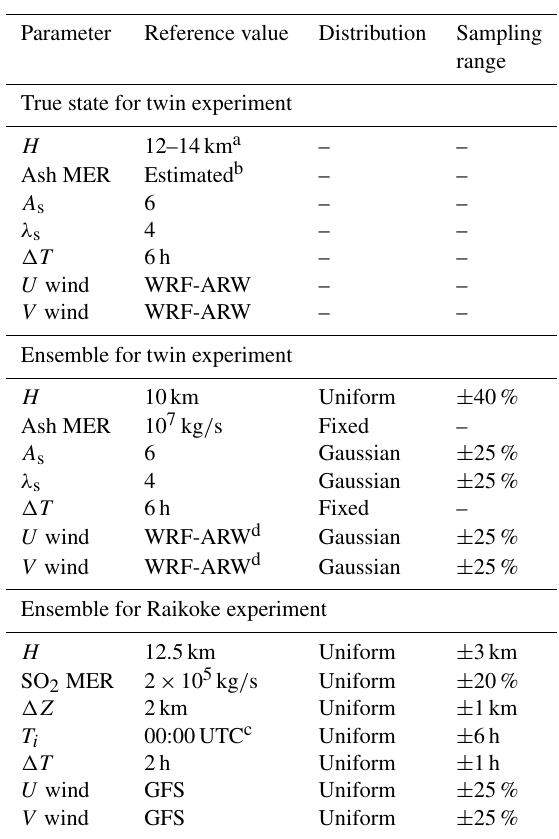
Table 2. Ensemble configuration for the twin and Raikoke exper- iments. In order to generate the ensemble, eruption source param- eters (ESPs) and wind components were perturbed around a refer- ence value using either uniform or truncated normal distributions. The Latin hypercube sampling (LSH) method is used to sample the parameter space. The perturbed ESPs are eruption start time ( T i ), source duration ( (cid:49)T ), eruption column height ( H ), mass emission rate (MER), parameters A s and λ s of the Suzuki vertical mass dis- tribution, and top-hat thickness ( (cid:49)Z ).